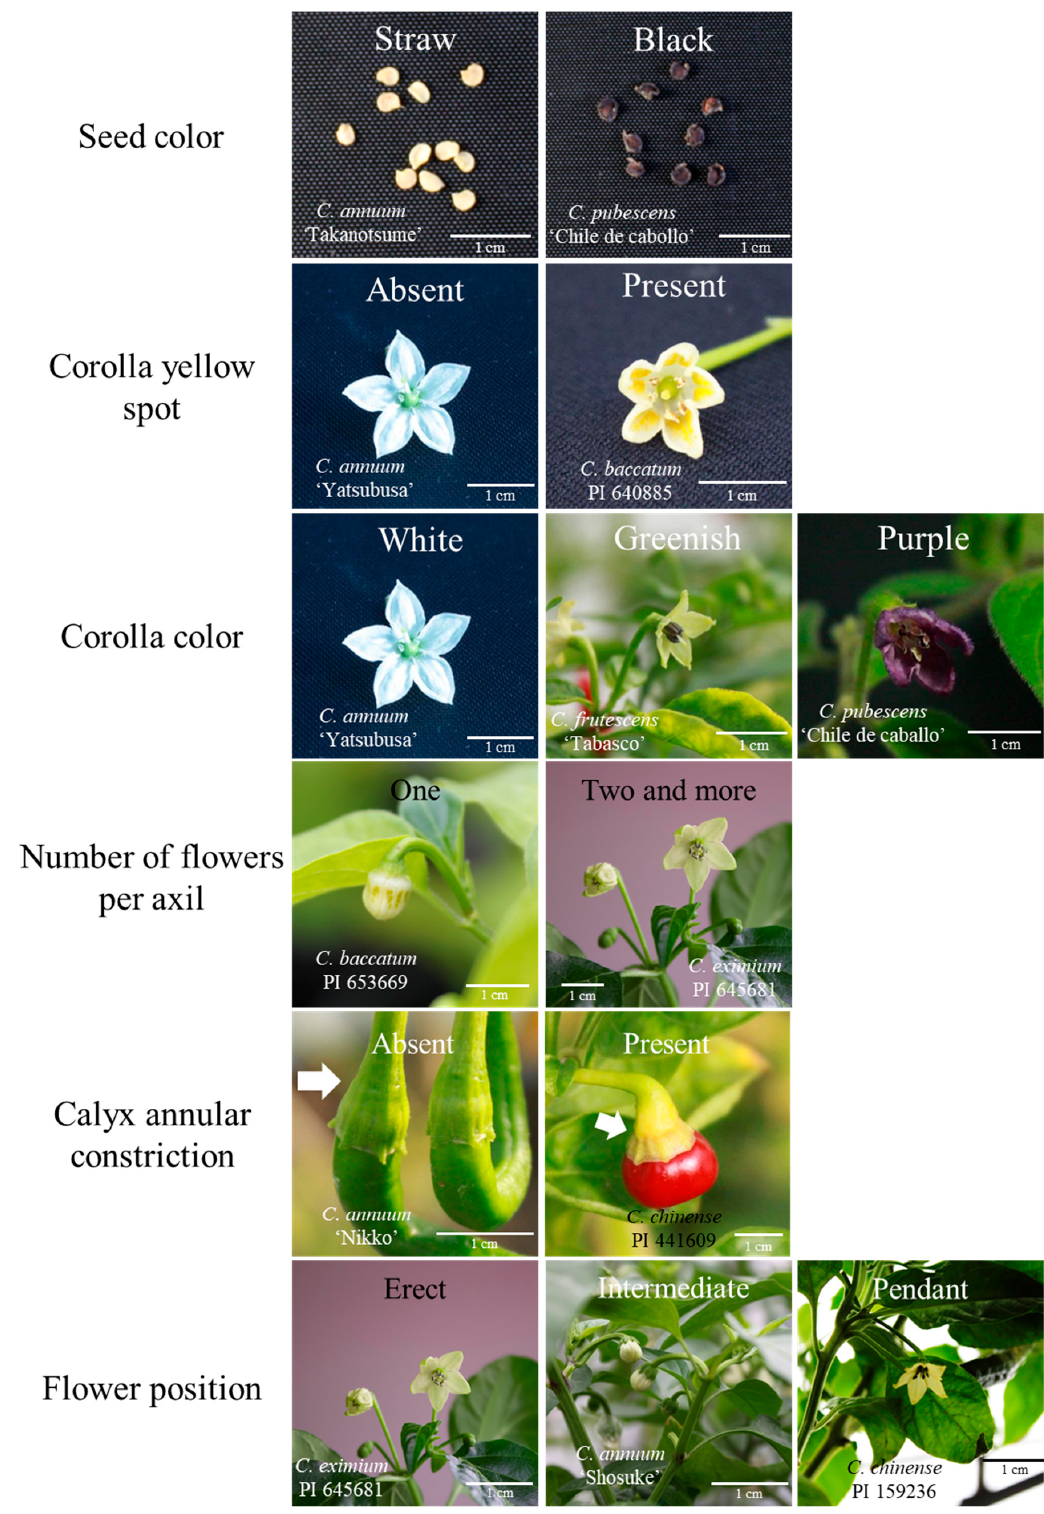
Figure 1. Traits for classification of domesticated species.